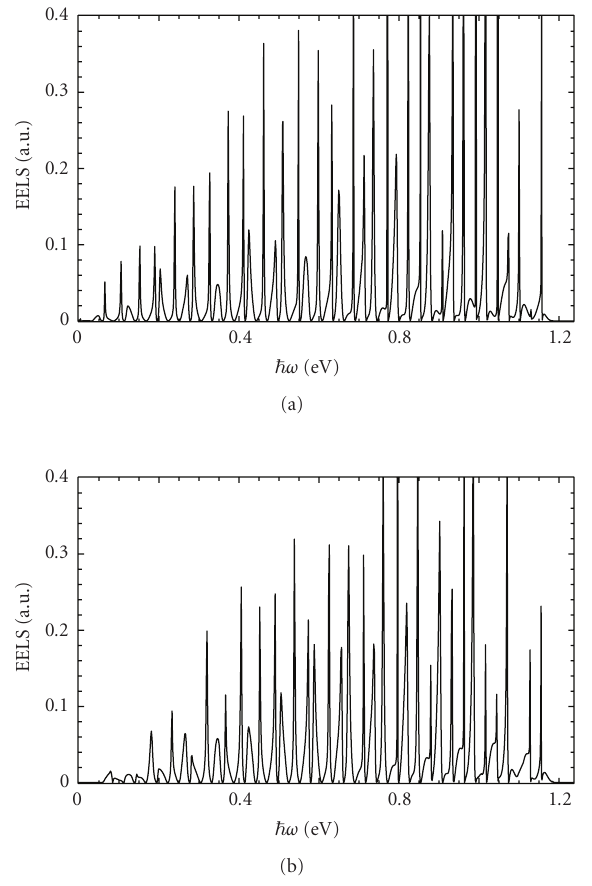
Figure 5: EELS for (a) 173-AGNR and (b) 100-ZGNR as a function of the irradiation